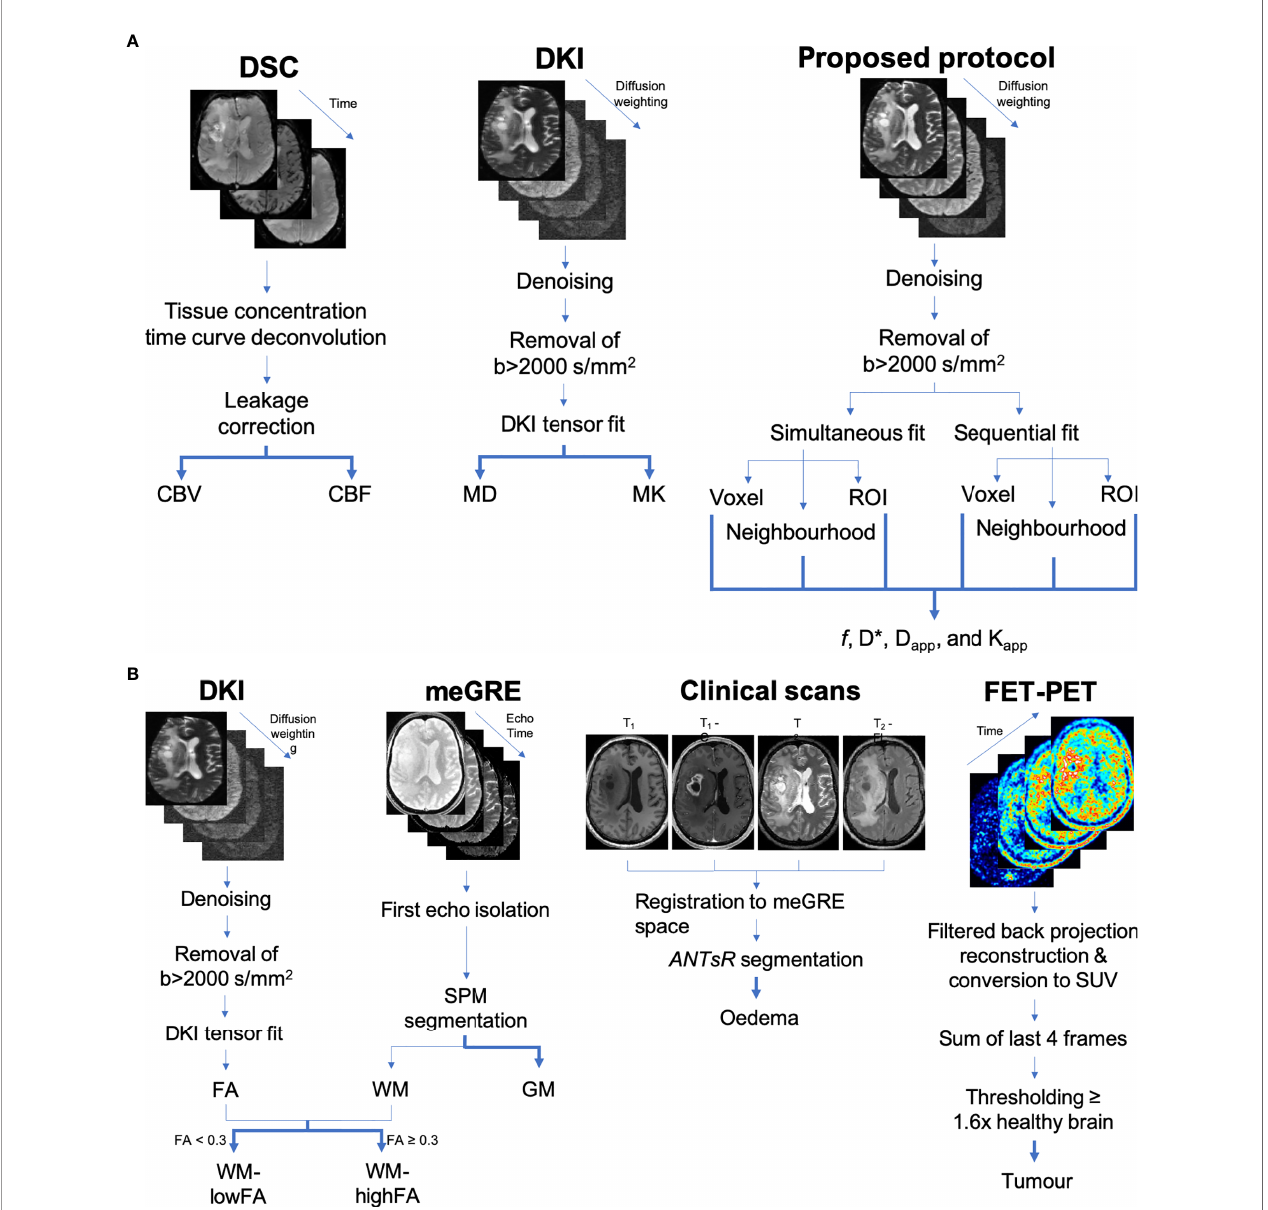
FIGURE 2 | (A) Flowcharts of the processing steps leading to the computed maps. (B) Flowcharts of the processing steps leading to the computed tissue